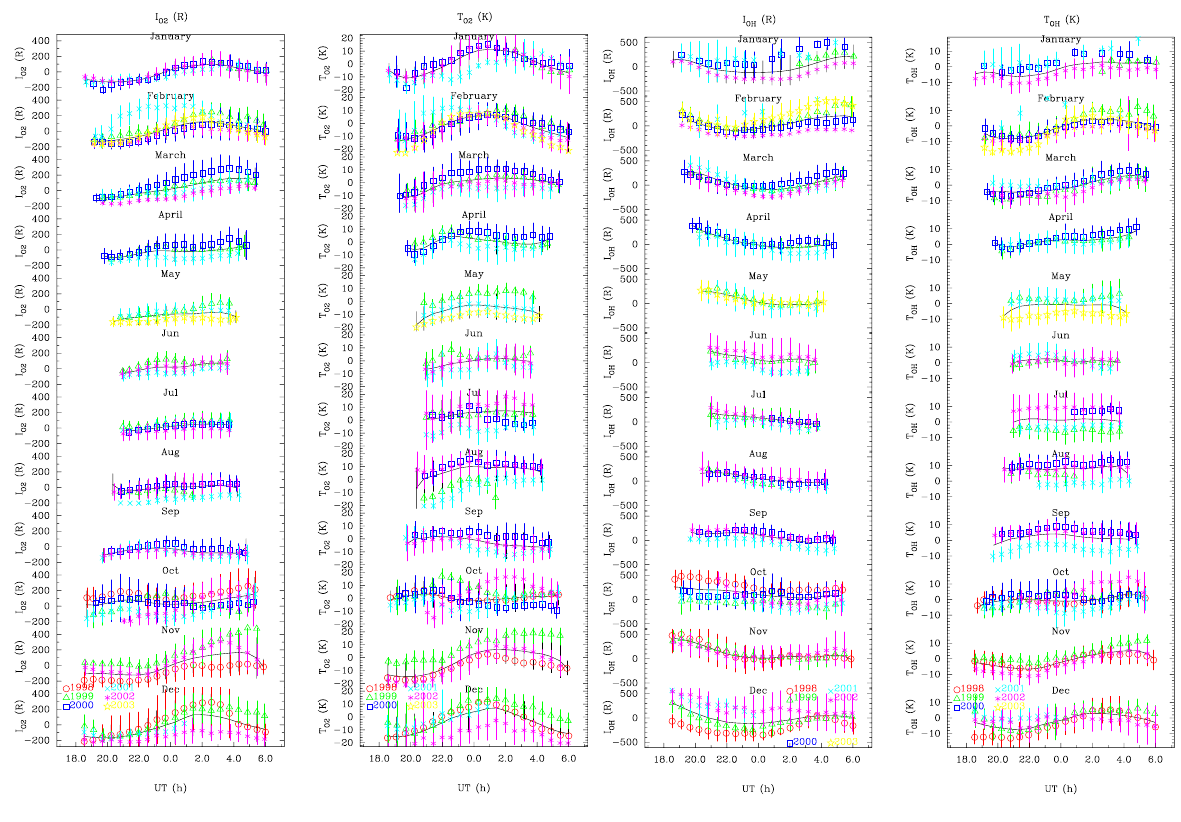
Fig. 1. Emission rates and rotational temperatures after removing seasonal annual and semiannual variations. Red circles: 1998. Green triangles: 1999. Blue squares: 2000. Blue crosses: 2001. Pink asterisks: 2002. Yellow stars: 2003. Solid line: Mean monthly night